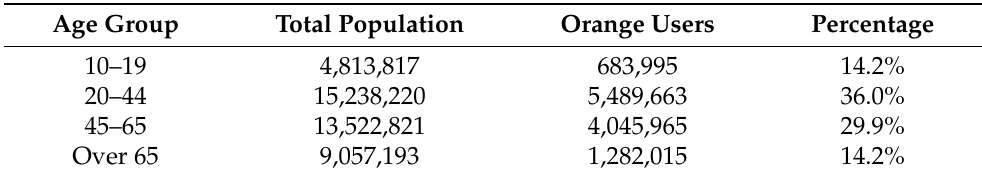
Table 1. Percentage of sample by age group. Sources: “Padrón Municipal de Habitantes” (2019) and Orange Spain (2019).